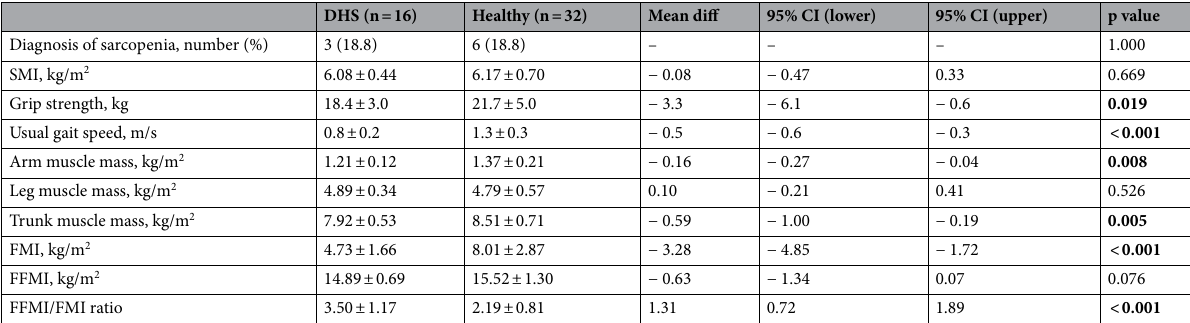
Table 2. Comparison of prevalence and clinical outcome between groups. Data are presented as mean ± SD. Bold figures indicate statistical significance with p < 0.05. DHS dropped head syndrome; SMI skeletal muscle mass index; FMI fat mass index; FFMI fat-free mass index.